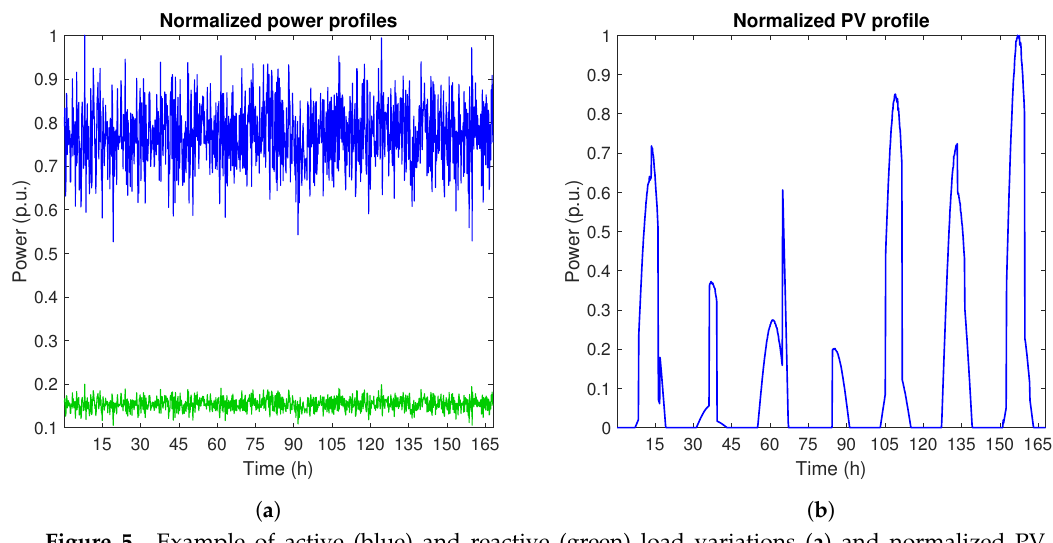
Figure 5. Example of active (blue) and reactive (green) load variations ( a ) and normalized PV production based on measured solar irradiance ( b